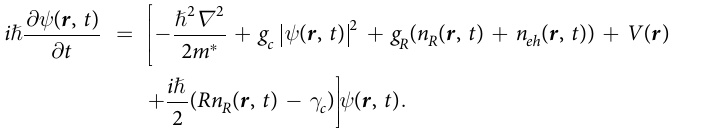
Fig. 2(b,c and d). The burst-like polaritonic emission pattern resembles the spatial-hole burning effect as observed in time evolution for polariton condensates in localized potential traps governed by slow reservoir relaxation 23 . In our case, one needs to take into account the ballistic propagation of emitted polaritons outside the pump spot. The polaritons escape from the defect potential trap due to strong repulsive interactions and are emitted radially.